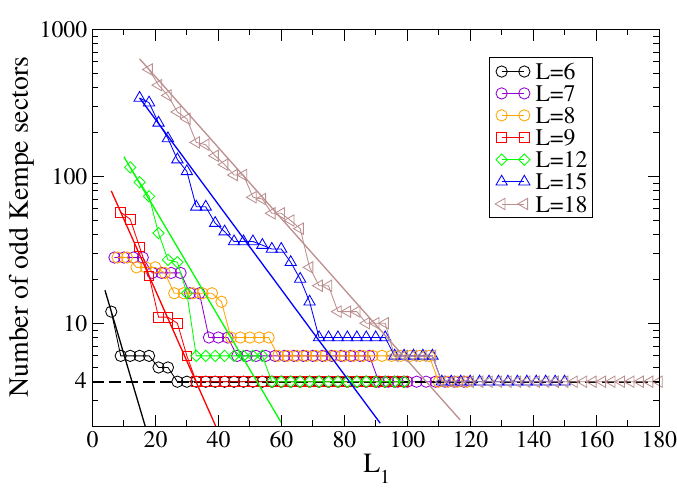
Figure 10: Multiscale reconnection of the odd Kempe sectors at size L when winding numbers up to L are allowed. By increasing L , the number of sectors decrease, 1 1 showing reconnections, down to the four (dashed line) odd sectors characterized by / L ) are shown for comparison (solid lines). the invariants. Decays as ∼ exp ( − L 1